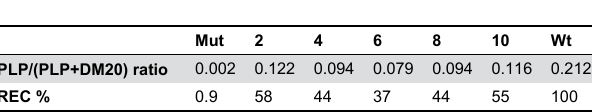
Legend: Columns 2, 4, 6, 8 and 10 indicate samples treated with 10 µM morpholino oligonucleotide in 2, 4, 6, 8 and 10 µM Endoporter reagent, respectively. The PLP/(PLP+DM20) ratio, obtained using the P2 and P23B sets of primers and probes, is reported for each sample. Rec % denotes the proportion of recovered PLP1 transcript expression as compared to the wild-type.